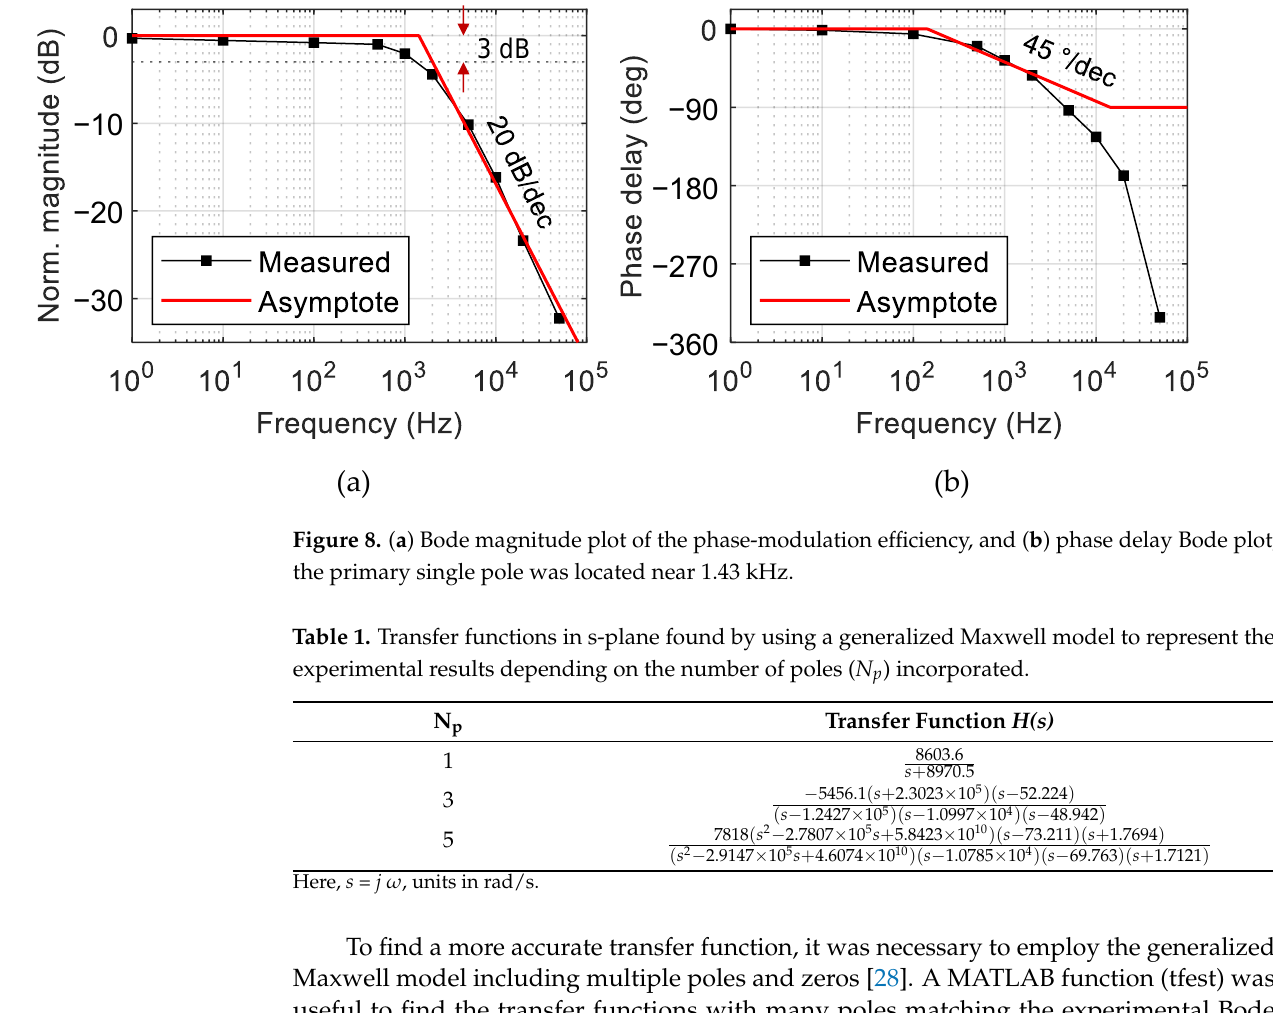
8 of 13 Figure 7. ( a ) Schematic of the 8-ch MZI array device. The PM microheaters on each channel were connected to the pads through connecting lines of different lengths, which led to variation in the heater resistance. ( b ) P  of the phase modulators and the resistance of the microheaters on each channel was measured to evaluate the fabrication uniformity of the array device. To characterize the temporal response of the phase modulator, a small amplitude signal introducing a phase change of π /10 was applied to the MZI phase modulator along with a DC bias. For various input signal frequencies, the amplitude and phase delay of the MZI out- put optical signal were measured to produce the Bode plot, as shown in Figure 8. By employ- ing the circuit analysis technique, transfer functions of the MZI were formulated from the Bode plots as summarized in Table 1. When the transfer function was approximated as a first- order system, the primary pole showed up at 1.43 kHz, which was close to the 3 dB bandwidth obtained from the Bode plot. Then, the 10 – 90% rising time τ ( 3 0 . 35 / d B f  ) given by the first- order RC circuit model became 265 μ s. This was somewhat larger than the response time of